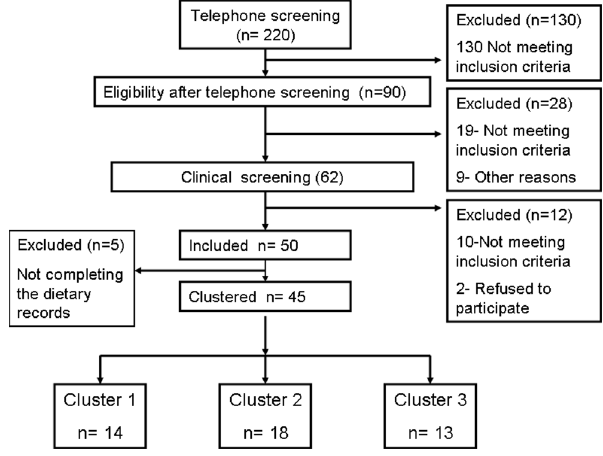
Figure 1. Consort Flowchart.